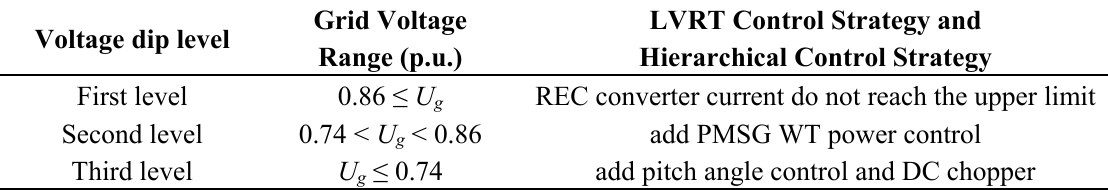
Figure 14. The LVRT coordinated control flow. Table 1. PMSG WT hierarchical control